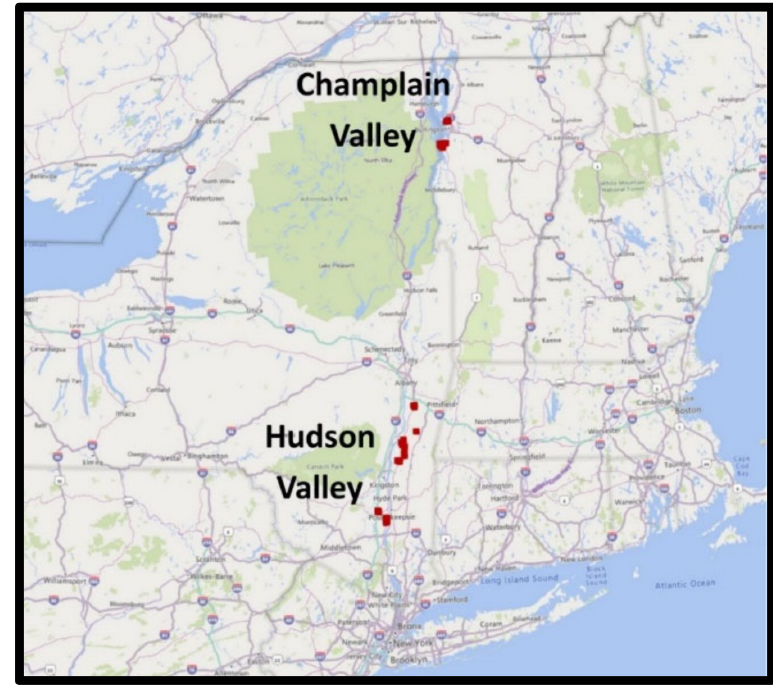
Figure 1. Map of the study domain in Eastern New York State,